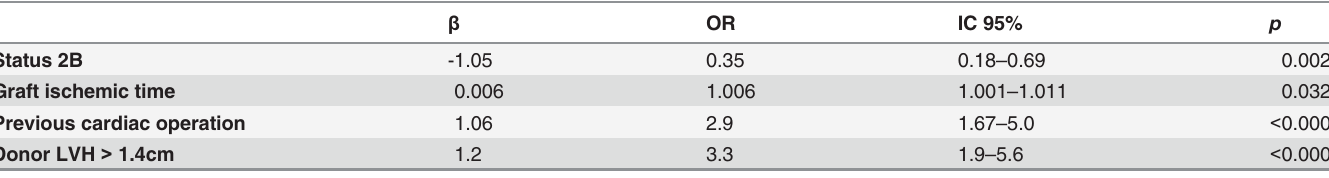
Table 5. Logistic regression modelling for troponin release > 10 μ